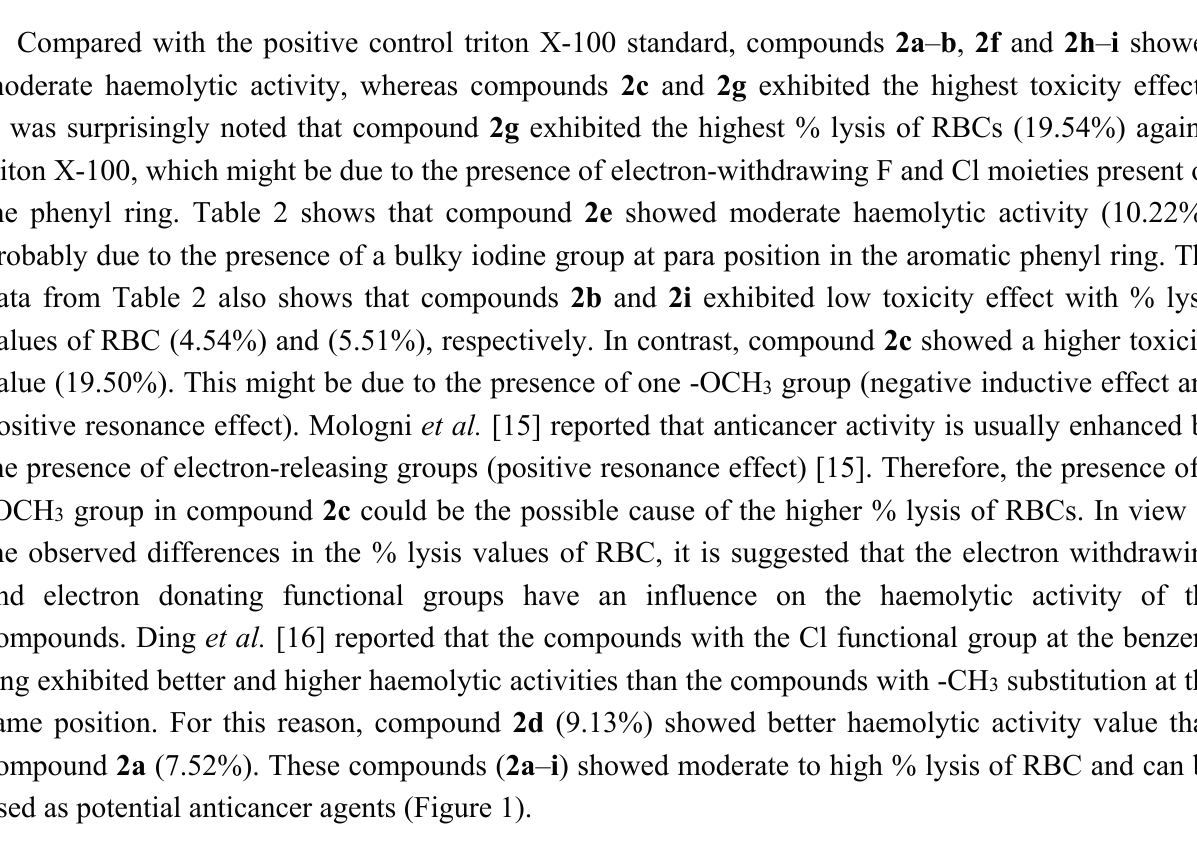
Table 2. Haemolytic activity data of 5-aryl-2-bromo-3-hexylthiophene based compounds ( 2a – i